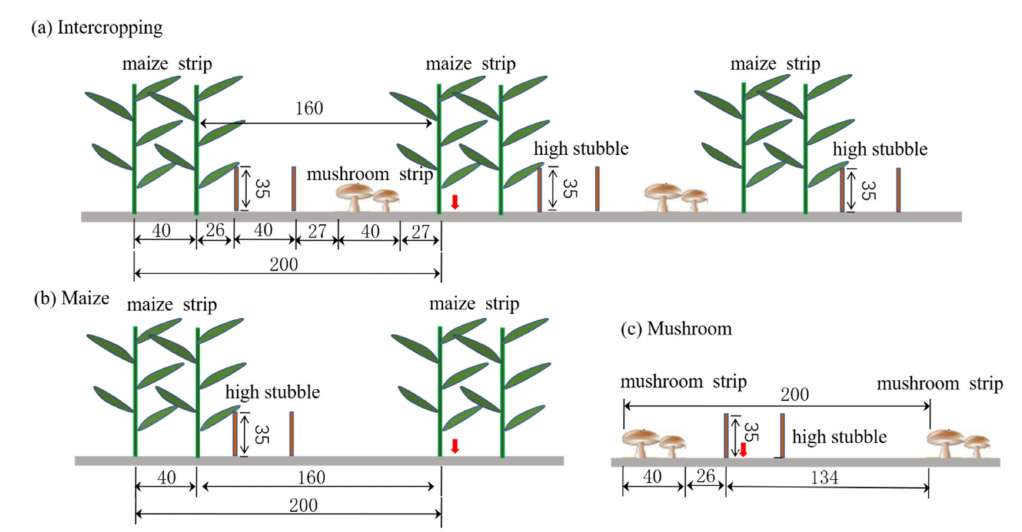
Figure 1. Schematic illustration of row placement of ( a ) maize–mushroom intercropping, ( b ) maize monoculture and ( c ) mushroom monoculture. Red arrows indicate the sampling point. The unit of distances is the centimeter